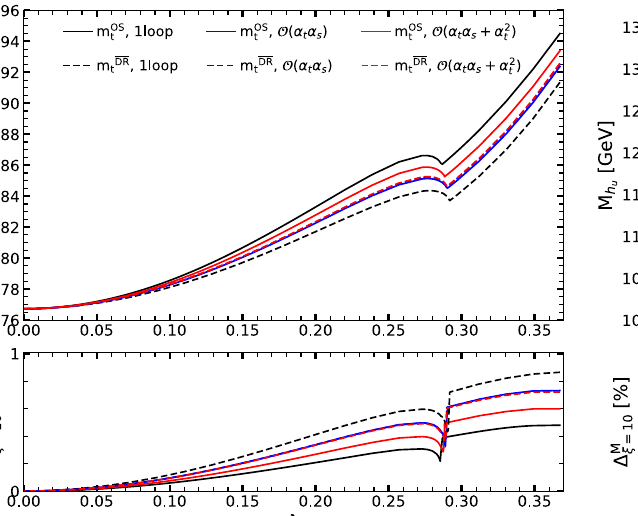
Fig. 5 Analogous to Fig. 4, but λ is varied while ξ is kept fixed at ξ = 10